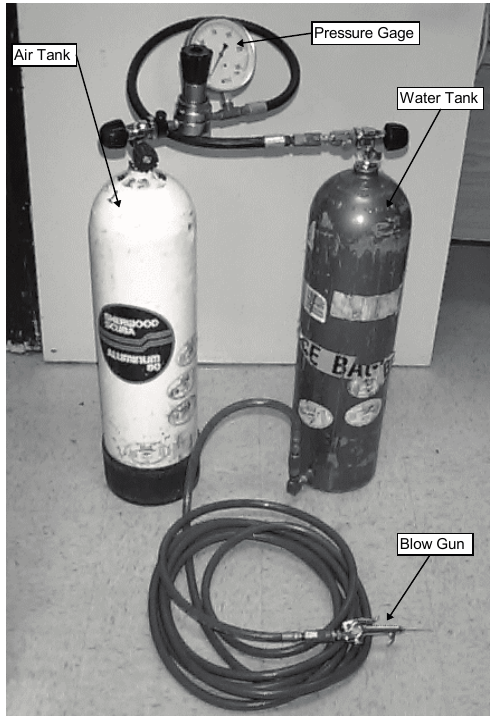
Figure 9. Water-jet method.